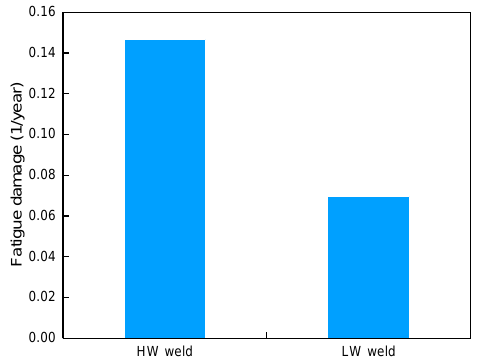
Figure 8. Fatigue damage of SW (H S = 3.25 m, T P = 9.5 s).